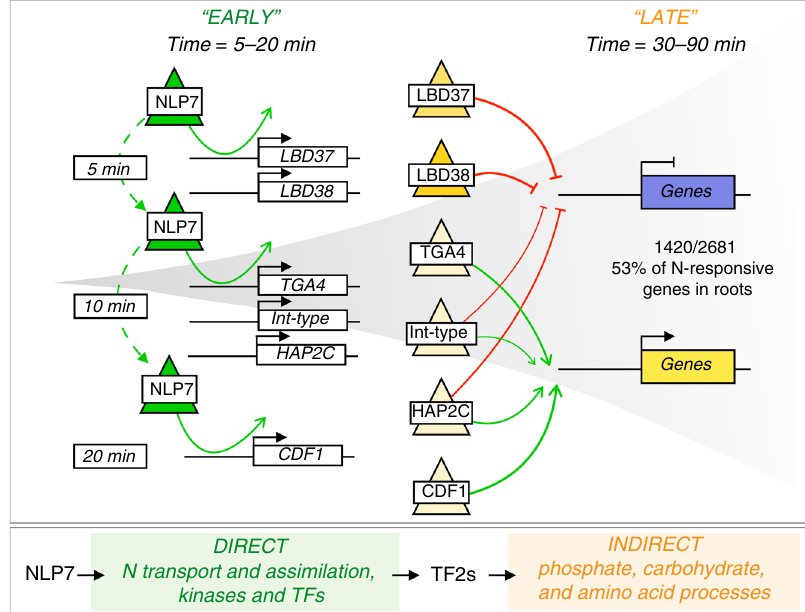
Fig. 6 A validated model for NLP7 role in rapidly initiating a cascade that ampli fi es the downstream N-response. Transient interactions of NLP7 initiate early N-response genes including genes involved in N-uptake and early N-response TFs. The transient interactions of NLP7 enable it to rapidly activate secondary TFs leading to a transcriptional burst in a short period of time. Secondary TFs amplify the NLP7-initiated cascade by regulating downstream late N response genes enriched in phosphate, carbohydrate, and amino acid processes (Supplementary Data 26). LBD37 and LBD38 primarily mediate transcriptional repression, and both have been shown to have in planta relevance 18 ; CDF1 and TGA4 primarily mediate transcriptional activation; and Int- type and HAP2C act as either gene activators or repressors depending on the target downstream of NLP7. Collectively, the direct targets of NLP7 and direct targets of secondary TFs account for 53% of the N response in plant roots 19